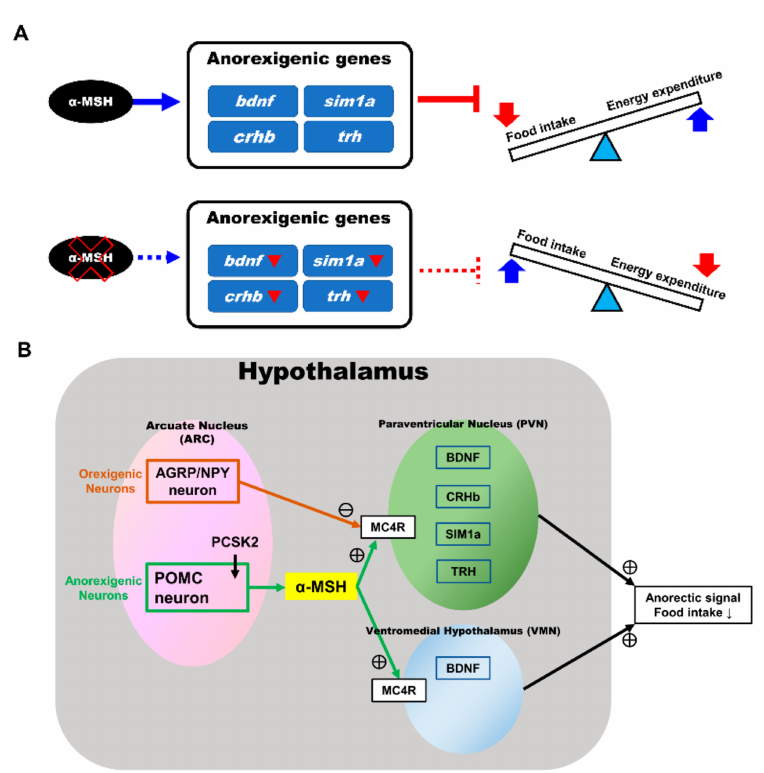
Figure 7. Anorexigenic signals in hypothalamic neural circuits promoted by α -MSH expression in zebrafish. ( A ) A proposed mechanism that α -MSH mediating food intake and energy expenditure via anorexigenic molecules manipulation which can reversed by α -MSH depletion. ( B ) Schematic presentation of anorexigenic factors ( bdnf , sim1a , crhb , and trh ) enhancement within the paraventricu- lar nucleus (PVN) and the ventromedial hypothalamus (VMN) by α -MSH resulting in a dramatic outcome with the anorexigenic